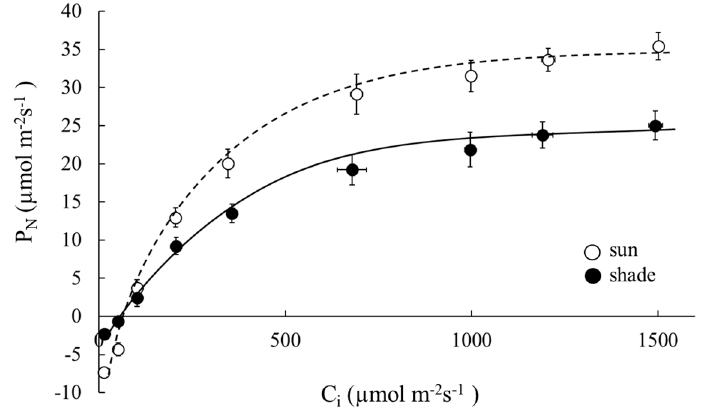
Figure 5. Response of the net photosynthetic rates to intercellular CO 2 concentration for sun and shade leaves of Robinia pseudoacacia . Values represent mean ± SE. Table 2. Estimated parameters of the photosynthetic rate curves for sun and shade leaves of Ro- binia pseudoacacia . Values represent mean (SE in parentheses). ANOVA was used to test the differ- ence between the leaf position at the 0.05 alpha level.